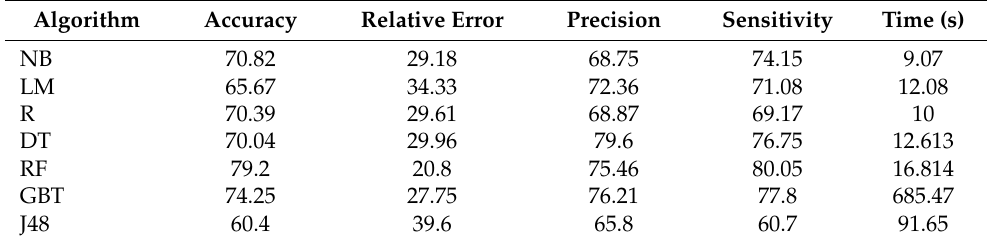
Table 6. Comparison between different algorithms applied on M-health data without preprocessing.